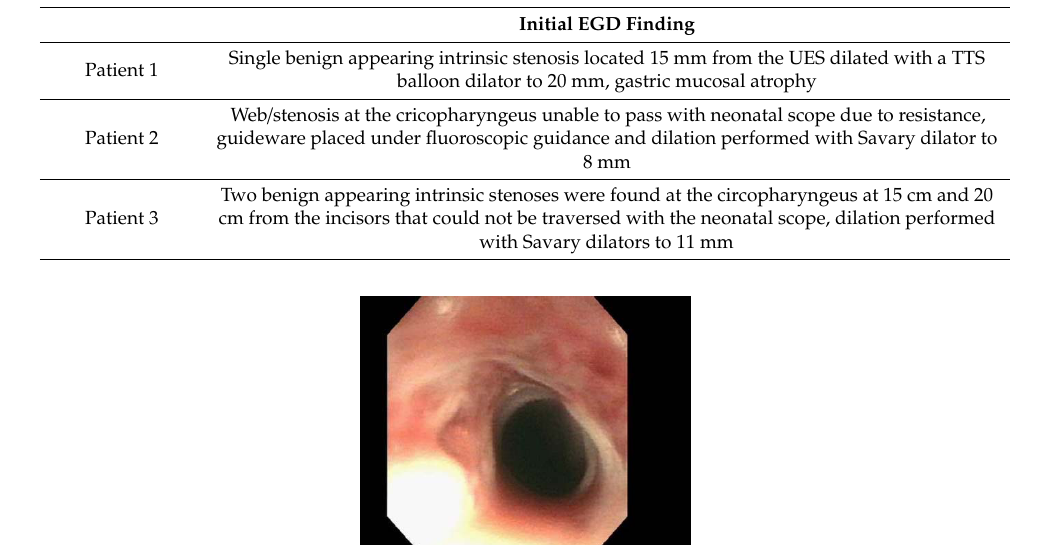
Table 3. Initial endoscopy findings and the interventions performed on the three patients with Plummer Vinson